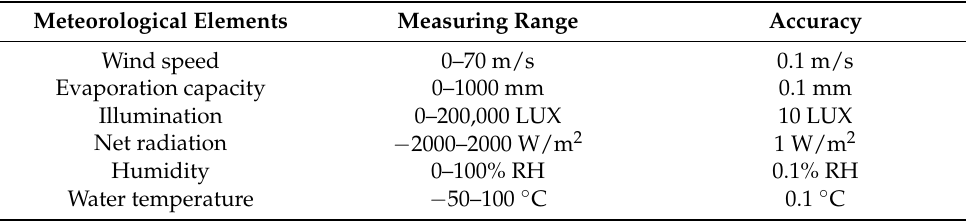
Table 3. Monitored items in the weather station.